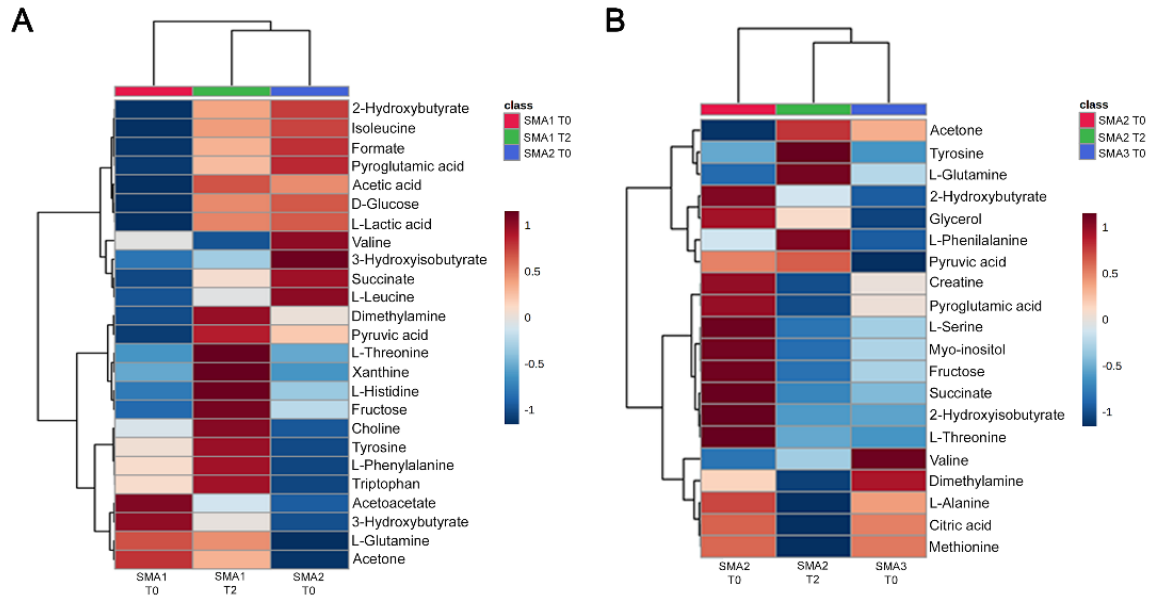
Figure 6. Comparative analysis of Nusinersen-dependent neurometabolic changes and disease severity. ( A , B ) Hierarchical clustering of metabolites identified by NMR analysis from the CSF of SMA1 (T0 and T2) and SMA2 (T0) patients ( A ) or SMA2 (T0 and T2) and SMA3 (T0) patients ( B ) shows that the metabolomic changes in treated SMA1 and SMA2 patients resemble the profile of untreated patients with a milder form of the disease. The heatmaps generated by MetaboAnalyst software are based on the Euclidean distance and Ward’s algorithm and are calculated based on the concentrations of discriminating metabolites with VIP > 1. For each metabolite, the bar color represents its abundance on a normalized scale from blue (low level) to red (high level). The dendrogram at the top is based on the similarity of the metabolomic profile relative to each sample cluster. The dendrogram on the left is based on the metabolite abundance profiles.